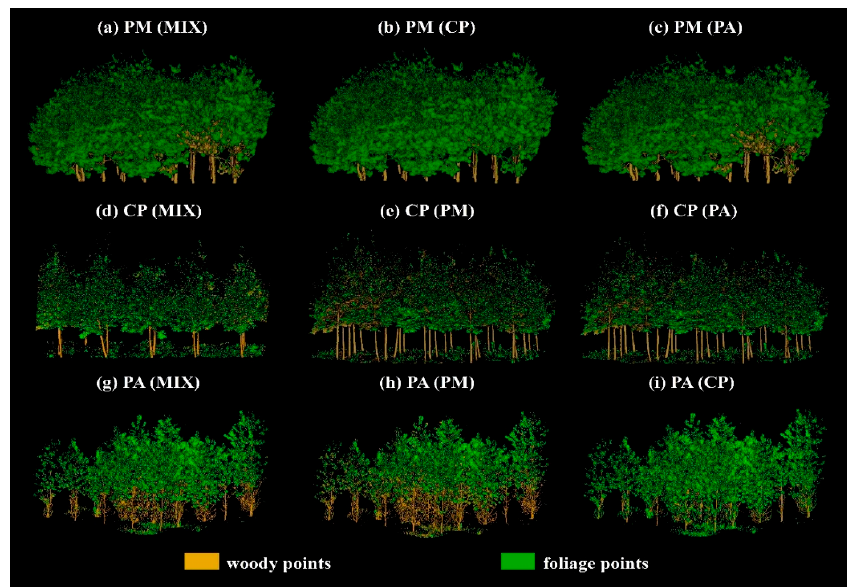
Figure 9. The subfigures ( a ) to ( i ) show the classification results attained using training point sets selected from TLS data of another plot (PA, CP, or PM) or the mixed training point set (MIX). For example, the PA (PM) means using the training point set selected from the PM data to train the FWCNN model to separate the TLS data of the PA plot. Table 4. The classification accuracy of using a training point set selected from one plot (PA, CP or PM) or mixed training point sets (MIX) to train the FWCNN model to separate woody and foliage points from the LRI-corrected TLS data. The F-T and W-T mean the number of foliage and woody points that were correctly classified within the test sets. The OA means the overall classification accuracy. The FPA and WPA mean the producer’s accuracy of foliage and woody points in the classification results, respectively.